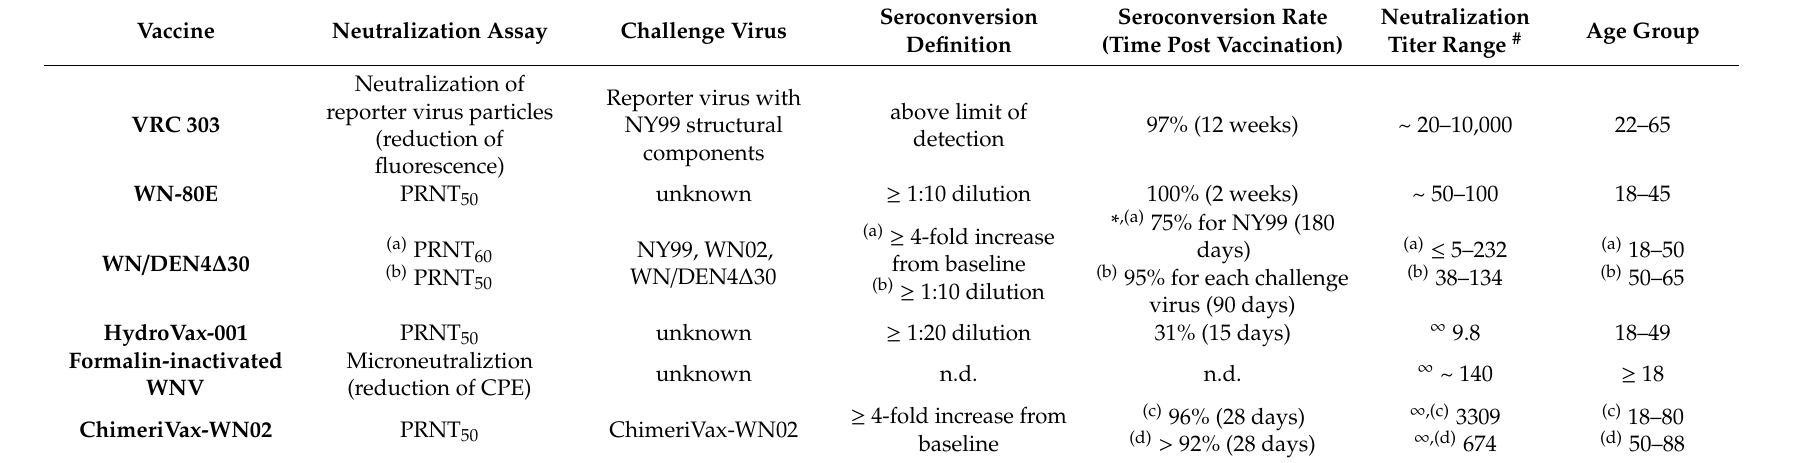
Table 2. WNV vaccine candidates use di ff erent assays to determine protection by